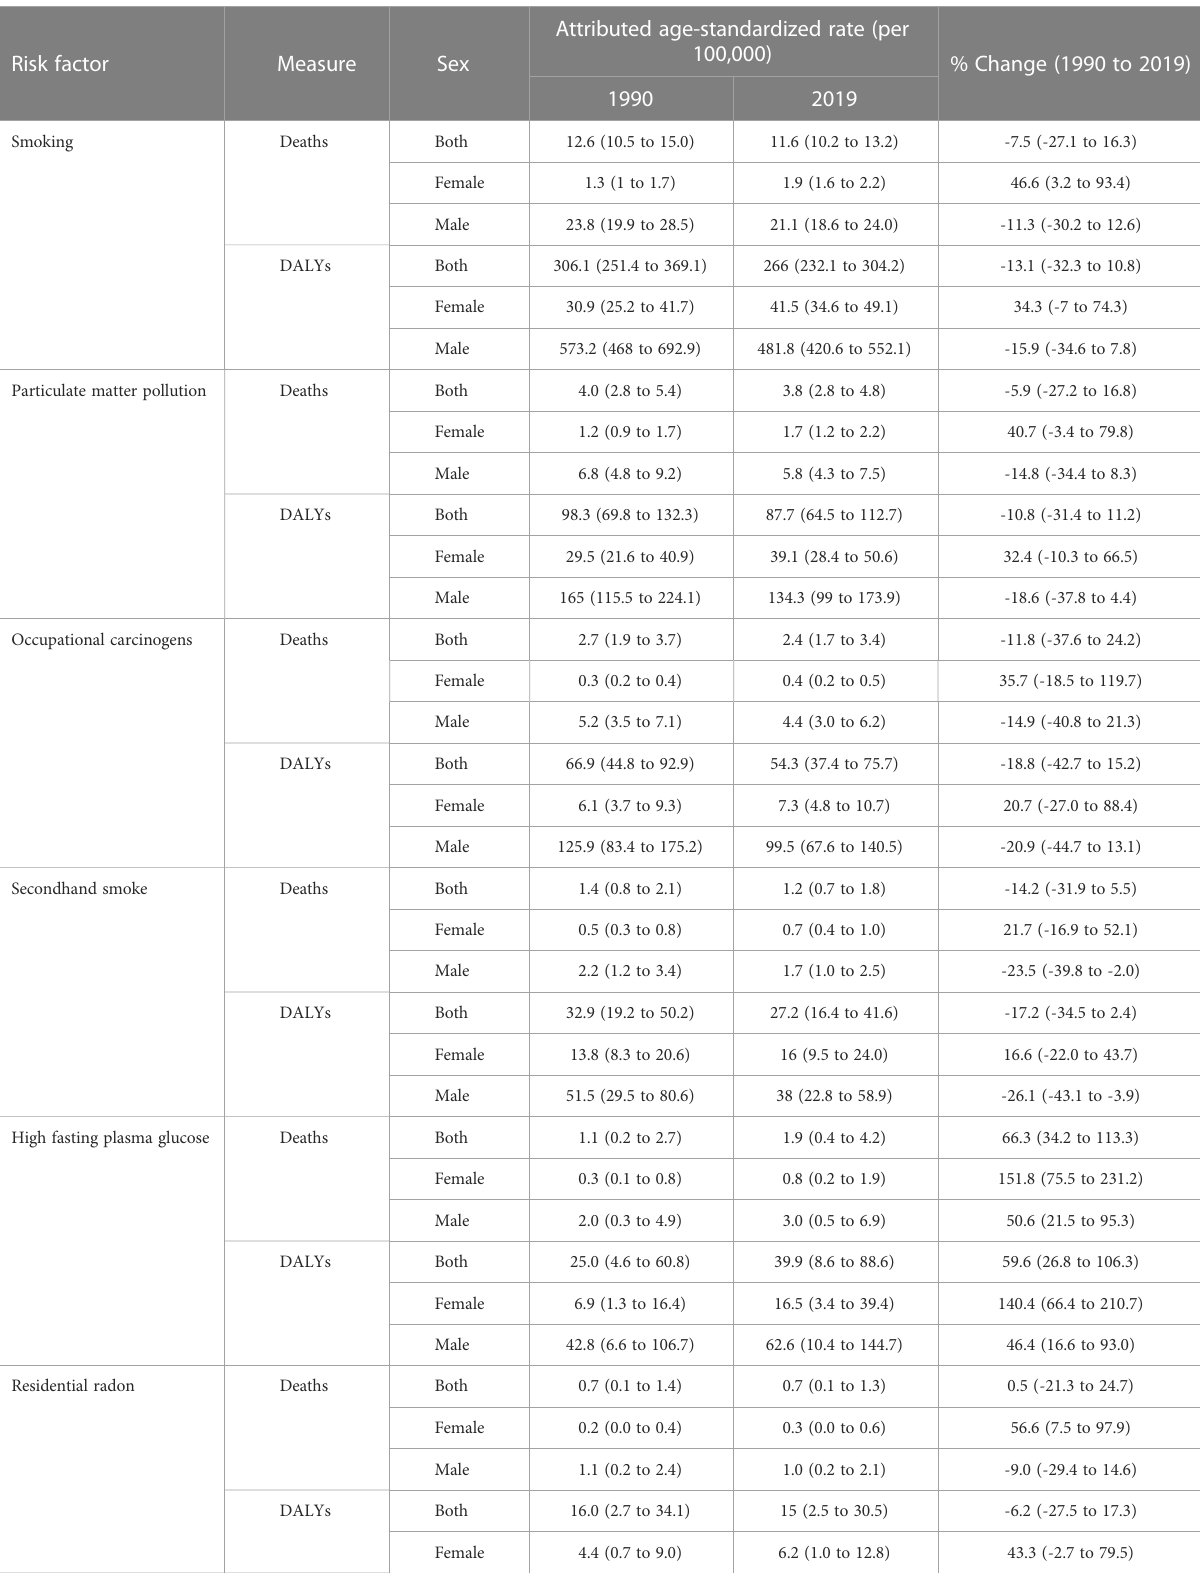
TABLE 4 Attributed age-standardized rate (per 100,000) of DALYs and deaths by risk factors in region by sex in 1990 and 2019 with their percent